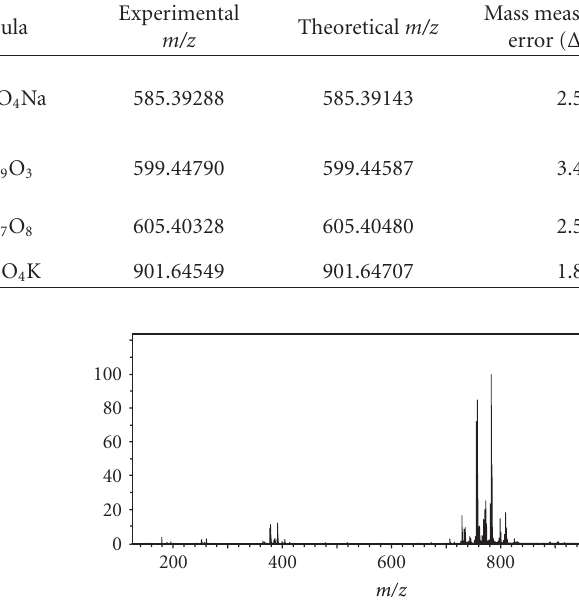
Figure 4: Broadband PS mass spectrum of 2 µ L CLSE, the spectrum was obtained by signal averaging 48 scans